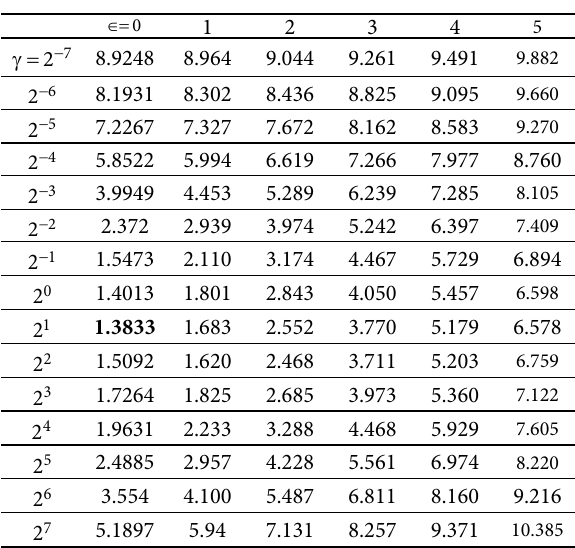
Table 6. Optimum SVR parameters estimation for Landsat 8 Tehran scene with C =